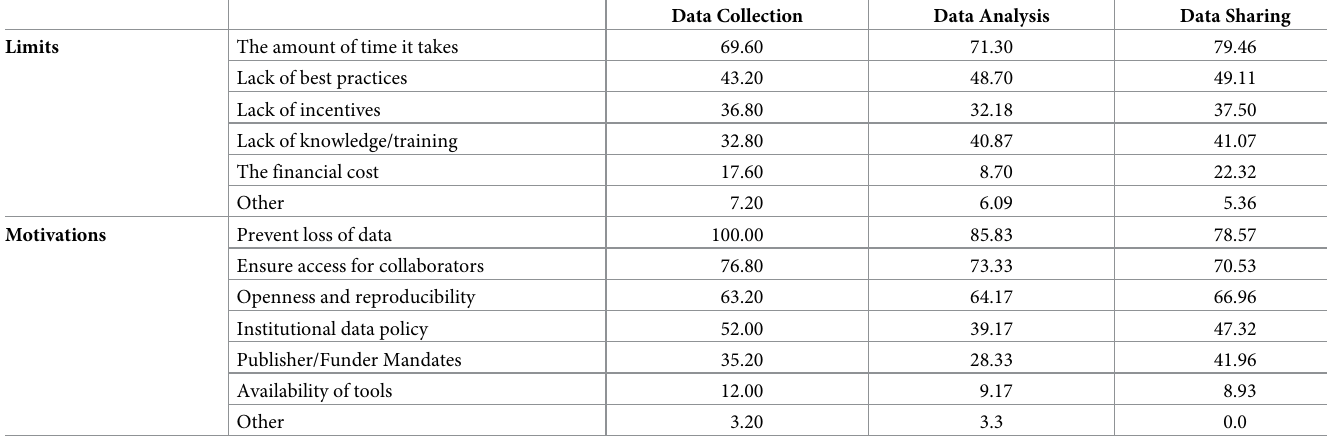
Table 2. Research data management limits and